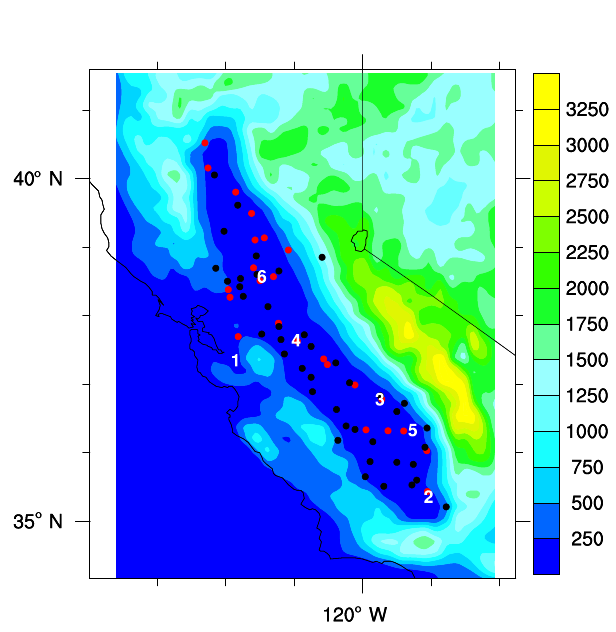
Figure 4. NOAA’s National Climatic Data Center (NCDC; 24 sta- tions, red dots), California Irrigation Management Information Sys- tem (CIMIS; 42 stations, black dots) and California Ambient Air Quality Data (six stations, numbers corresponding to Table 2 sta- tion ID) measurement locations. Terrain height in m is